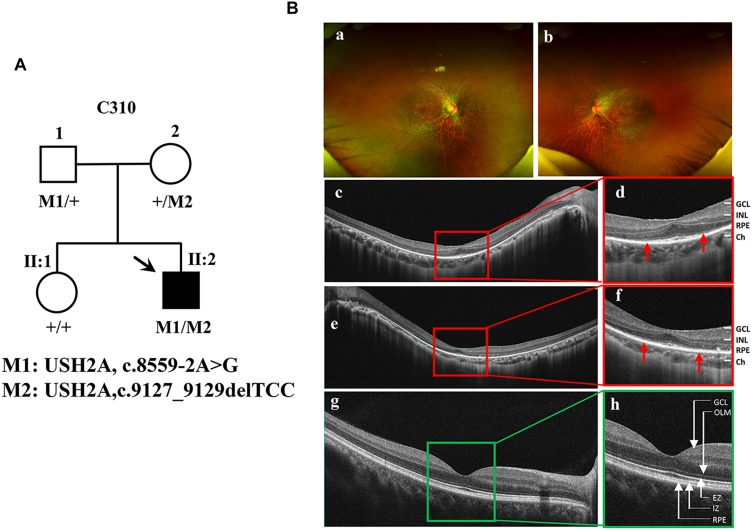
Identification of a novel pathogenic mutation of the USH2A gene in RP. (A) Pedigrees and mutations segregating in family C310. Males and females are represented by squares and circles, respectively. The symbols for affected family member are filled. The symbols for proband with black arrow. The genotype of each evaluated individual is shown below the individuals’ symbol and identification number. Abbreviations: Wild type (+); c.8559-2A > G (M1); c.9127_9129delTCC (M2). (B) Fundus images of the proband and health control. Fundus photographs showed the abnormal pigmentation in the peripheral area in both eye of the proband (a,b). Loss of outer limiting membrane (OLM), ellipsoid zone (EZ) and interdigitation zone (IZ) was visualized by SD-OCT in the proband (c–f), when comparing to the normal eye (g,h).